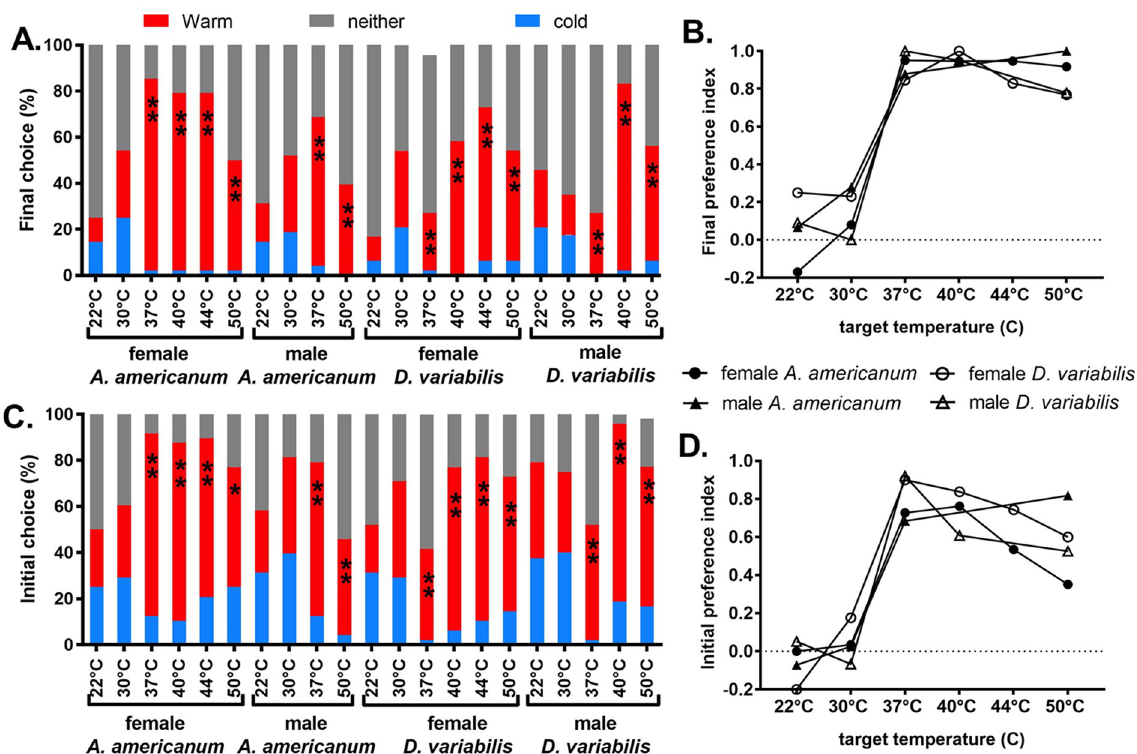
Fig 5. Thermotaxis trials scored as choice tests. (A) Final choice of ticks at the end of a 5 min trial was scored as “warm” or “cold” if within 10 cm of the corresponding end, or “neither” if between those end areas. (B) Final warm preference index (PI), defined as (warm-cold)/(warm +cold) [20]. (C) Initial choice scores based on direction of the first movement of more than 15 cm if the tick eventually moved at least 25 cm from the origin. Ticks that failed to move at least 25 cm were scored “neither”. (D) Initial warm PI. Significance of warm/cold difference: �� : p < 0.001; � : p <